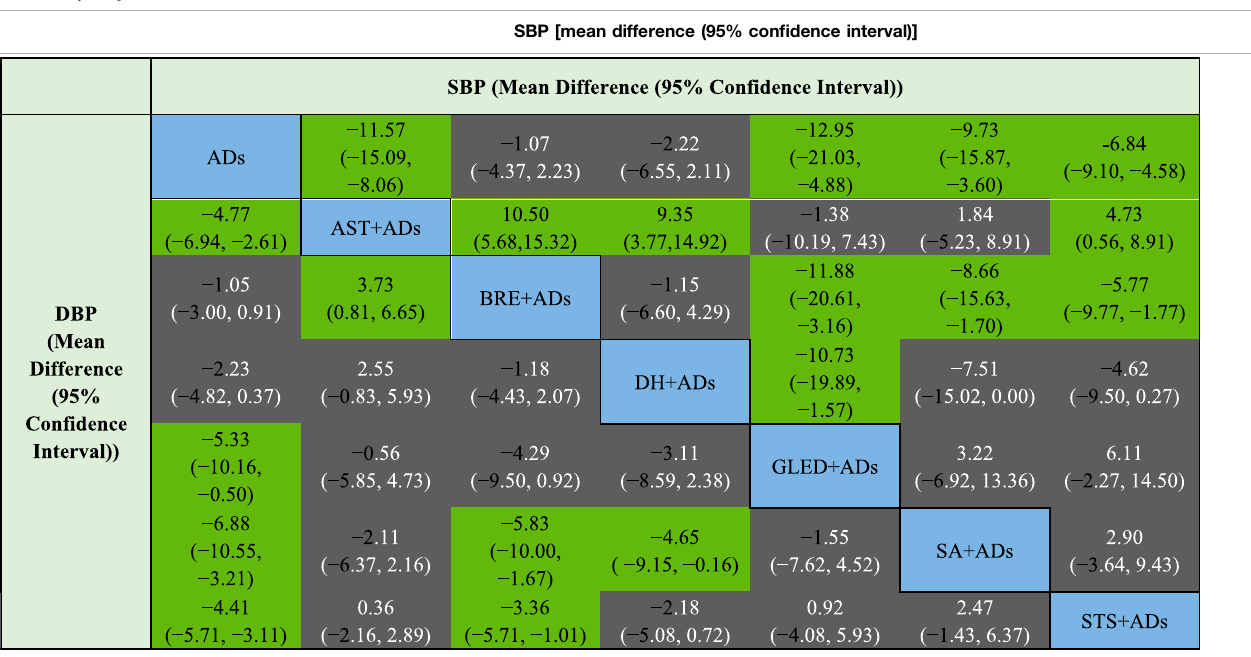
TABLE 2 | League table for SBP and